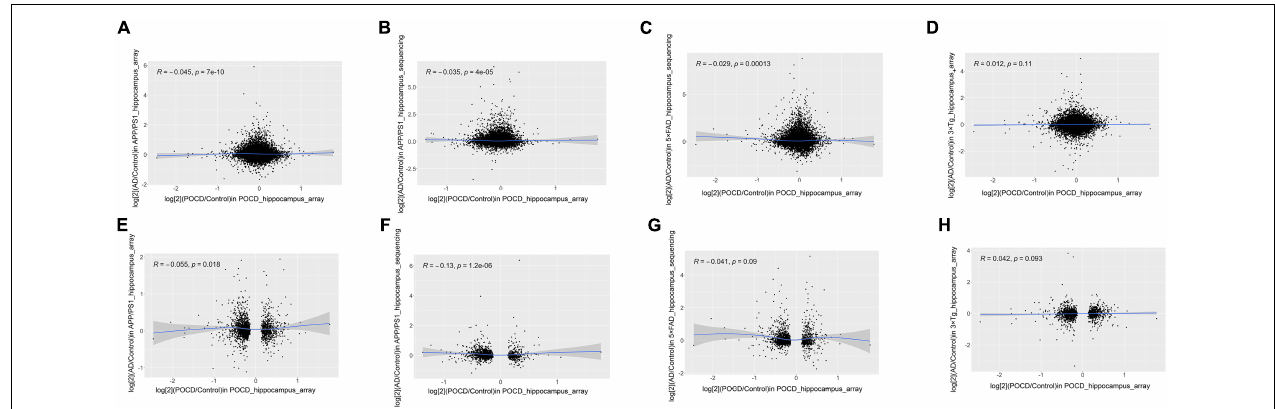
FIGURE 2 | Correlation analysis of all (A–D) and significantly dysregulated (E–H) protein-coding gene expression fold-changes between POCD and different AD transgenic models in the hippocampus. (A) GSE95426 (POCD model microarray data) vs. GSE135999 (APP/PS1 model microarray data); (B) GSE95426 vs. GSE93678 (RNA-seq data from APP/PS1 model); (C) GSE95426 vs. GSE168137 (RNA-seq data from 5 × FAD model); (D) GSE95426 vs. GSE165111 (3 × Tg model microarray data). (E) GSE95426 (POCD model microarray data) vs. GSE135999 (APP/PS1 model microarray data); (F) GSE95426 vs. GSE93678 (APP/PS1 model RNA-seq data); (G) GSE95426 vs. GSE168137 (5 × FAD model RNA-seq data); (H) GSE95426 vs. GSE165111 (3 × Tg model microarray data).